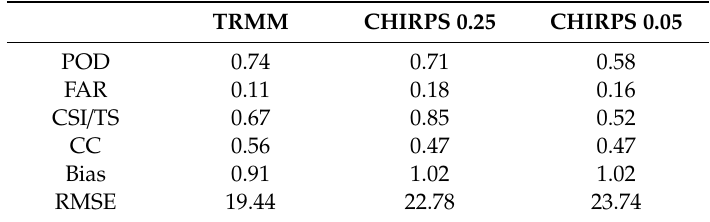
Table 3. Categorical and continuous statistical values of precipitation